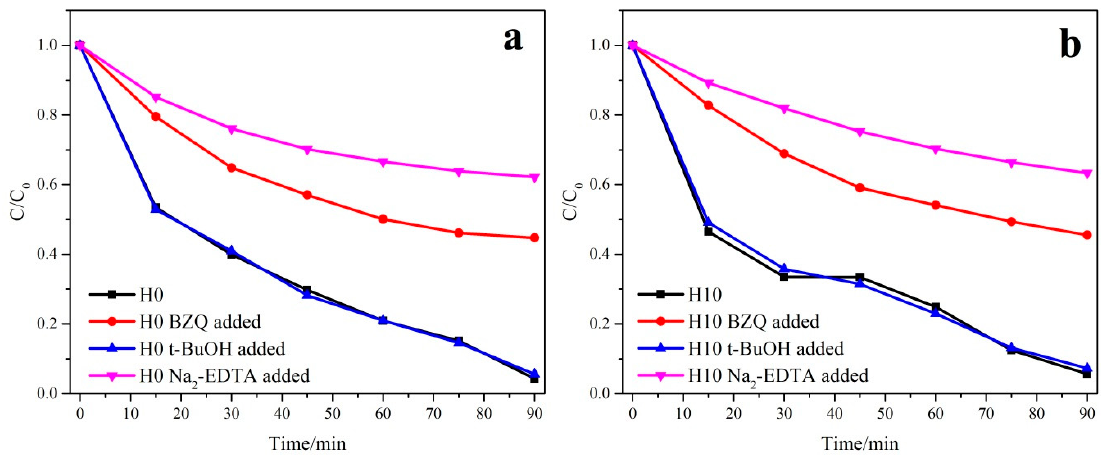
Figure 6. Trapping experiments of photocatalytic degradation of both H0 ( a ) and H10 ( b ) samples with/without the presence of scavengers.